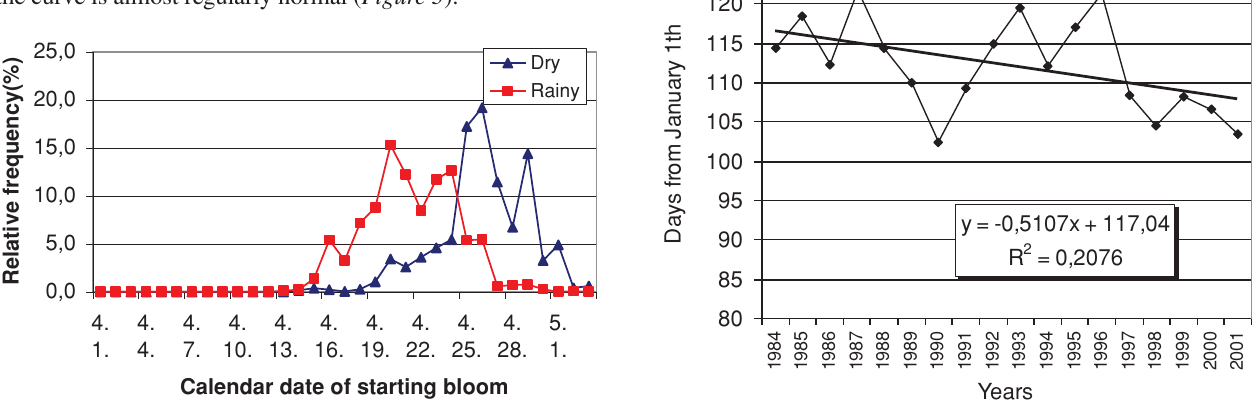
spring temperature maxima, the mean temperature of the spring as well as the difference between the mean day- time and night–time temperatures produced a signifi cant correlation with the start of bloom on the level of P=5%. We have also found signifi cant correlation between minimum temperature and beginning of bloom ( Figure 5 ).